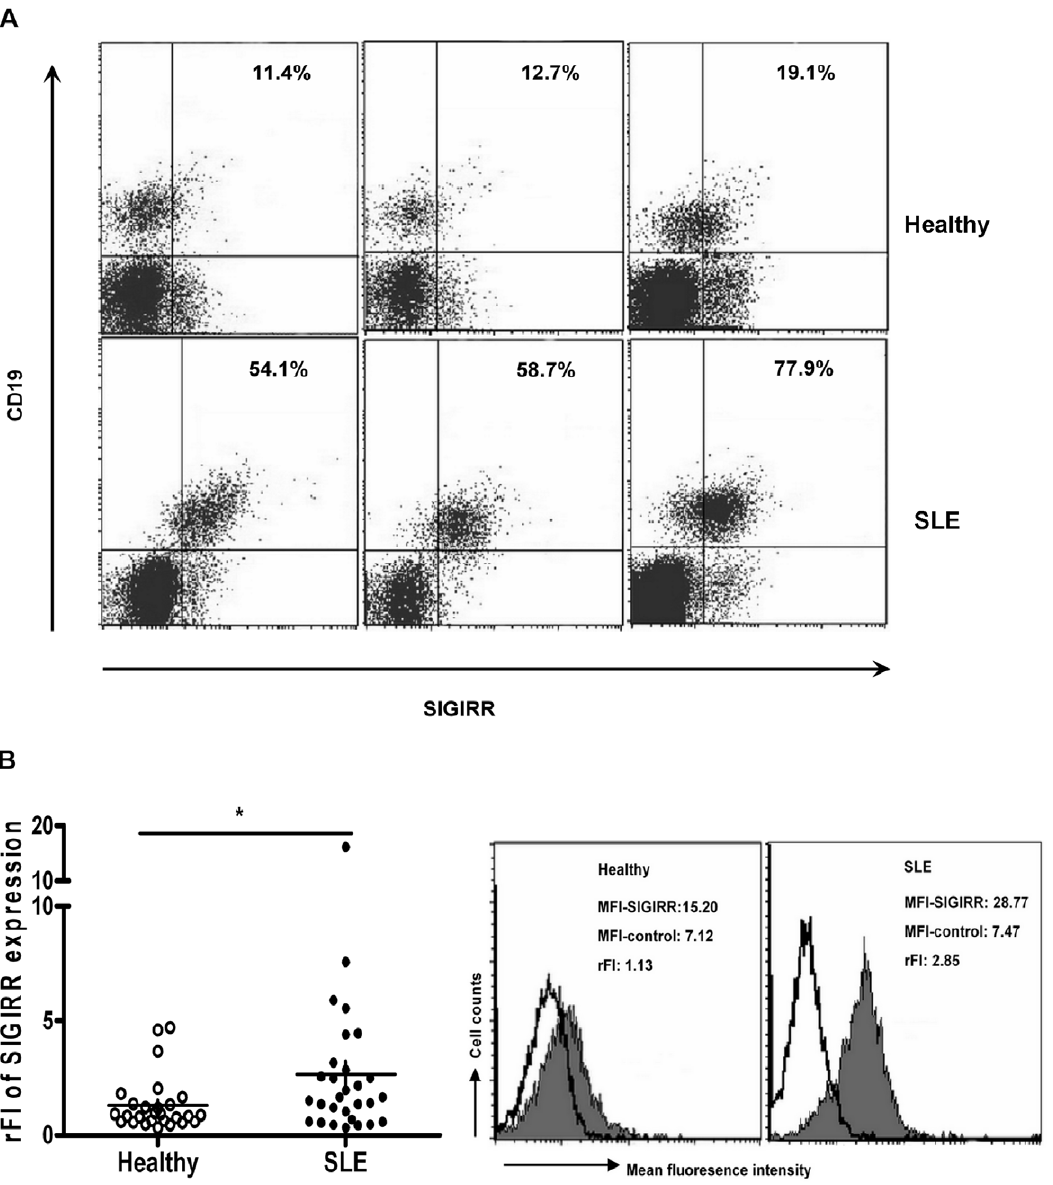
Figure 3. SIGIRR expression by B cells from SLE patients (n=29) and healthy controls (n=27). SIGIRR expression was analyzed by flow cytometry following staining with anti-CD19 and anti-SIGIRR antibodies. A. The staining profile of representative samples from SLE patients and healthy subjects, three for each. The numbers indicate the percentage of CD19 + SIGIRR + cells. B. The expression levels of SIGIRR in SLE and control B cells as measured by rFI. The histograms on the right show SIGIRR expression (shaded area) on CD19 + cells from a representative SLE patient and a representative healthy subject. The black line represents a control with FITC-labeled secondary antibody alone. The inserted numbers indicates MFI with anti-SIGIRR antibody (MFI-SIGIRR), MFI with secondary antibody alone (MFI-control), and the deduced rFI. The panel on the left shows the rFI value for each individual subjects. The horizontal bar denotes the mean. Statistical significance was tested by non-paired t test. * P , 0.05.